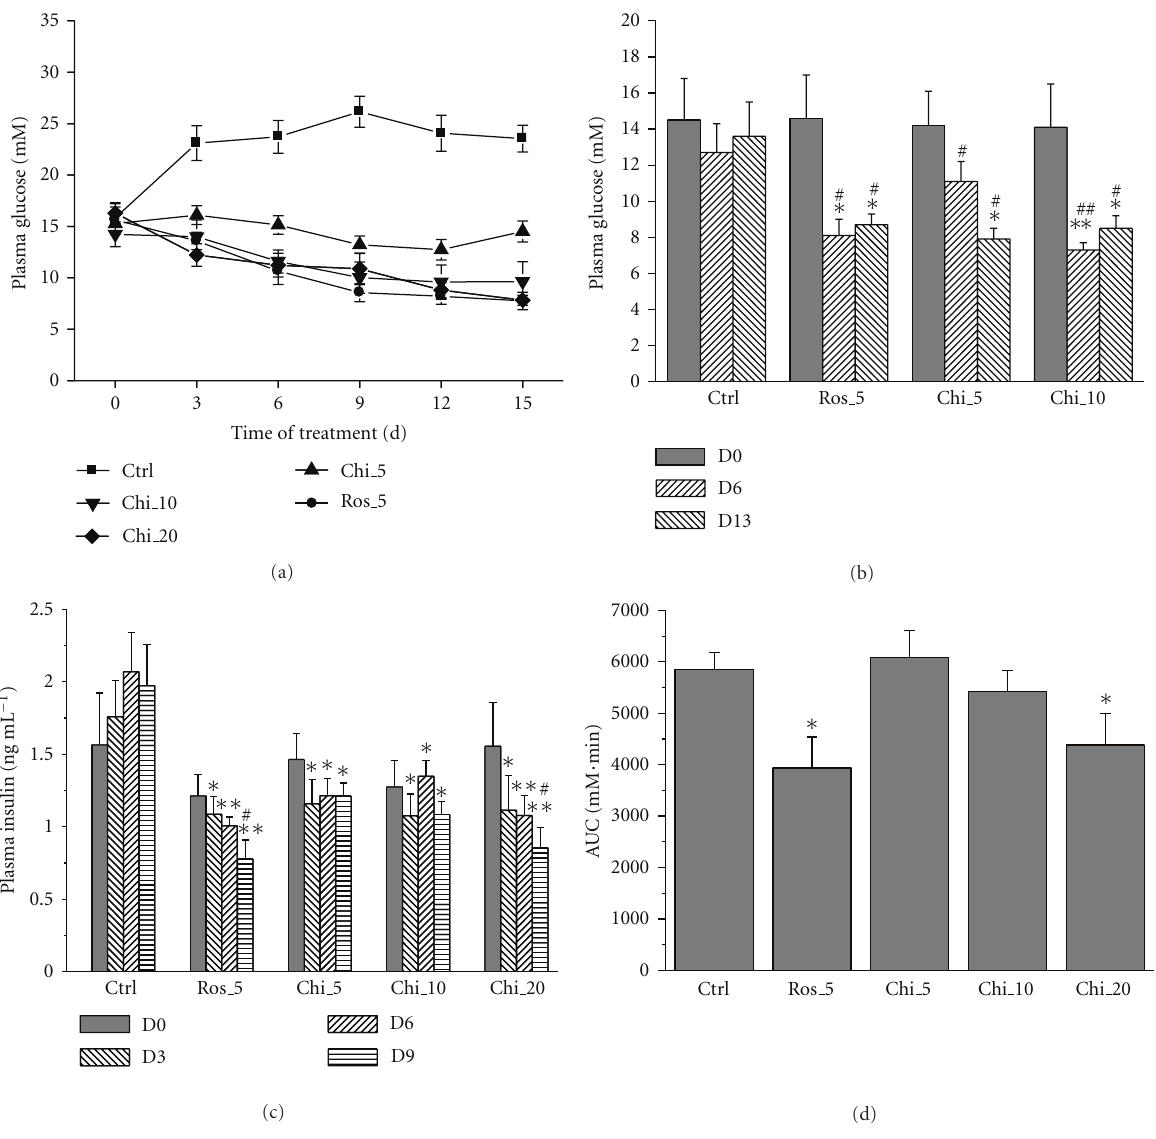
Figure 2: In vivo e ff ects on blood glucose control and insulin sensitization of chiglitazar. Male db/db (a, c and d) and male KKAy mice (b) were treated with vehicle (Ctrl), rosiglitazone (Ros), or chiglitazar (Chi) at the indicated doses for various days. Plasma glucose (a and b) and insulin (c) levels were measured at the indicated time points. Glucose tolerance (d) was evaluated and the results are presented as the area under curves (AUC) generated from 0, 30, 60, and 120 min after the glucose load. ∗ P < 0 . 05, and ∗∗ P < 0 . 01 compared with Ctrl; # P < 0 . 05 and ## P < 0 . 01 compared with day 0. n = 10 per group for db/db mice, and n = 8 per group for KKAy mice. Data are expressed as mean ±